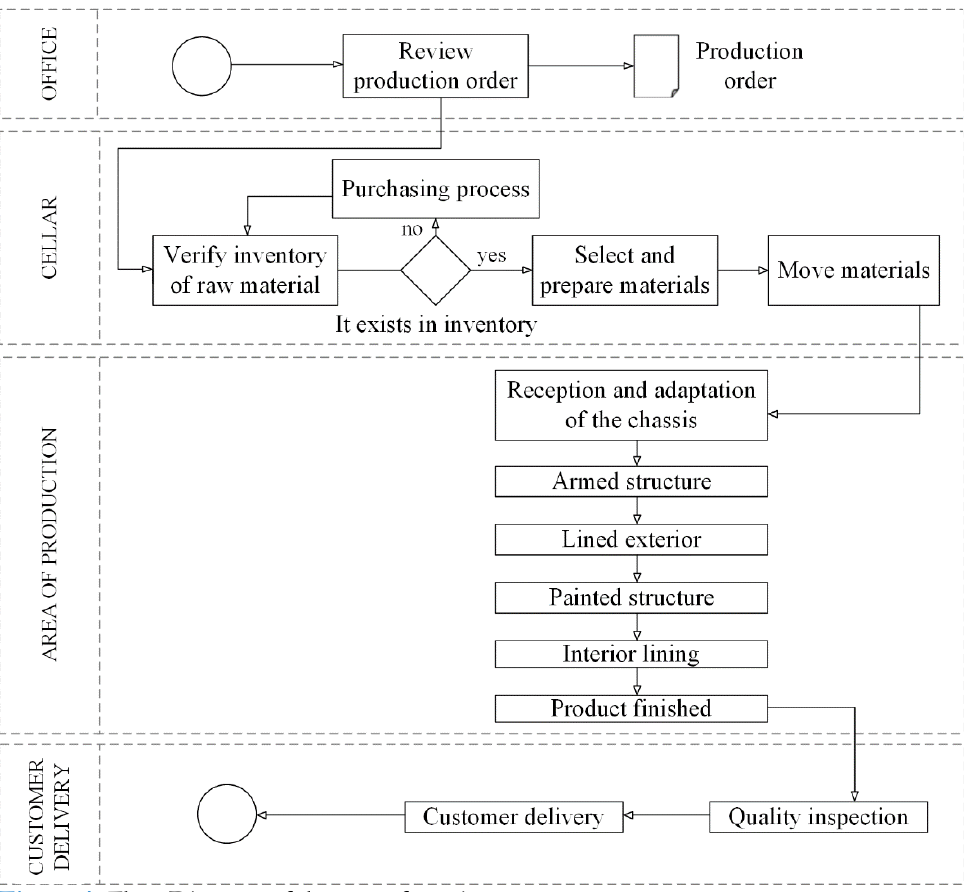
Figure 1. Flow Diagram of the manufacturing